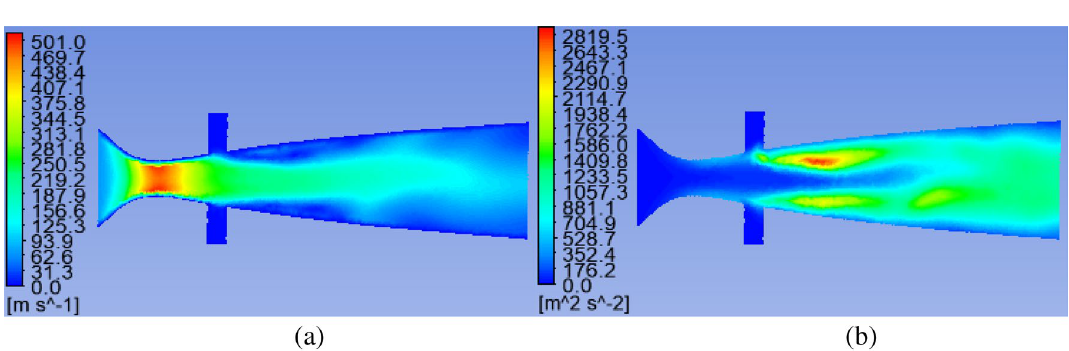
Figure 3. Internal cloud map of supersonic nozzle. ( a ) Velocity cloud map. ( b ) Turbulent kinetic energy cloud